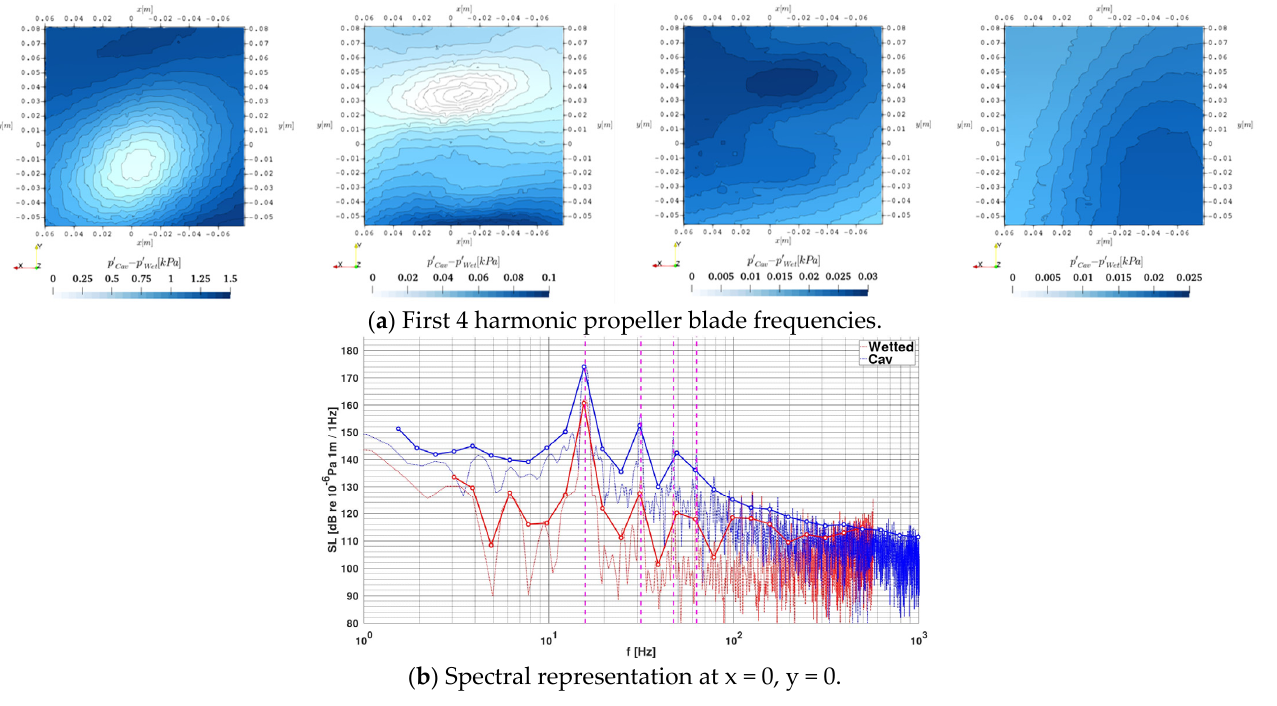
Figure 6. Difference between cavitating and non-cavitating